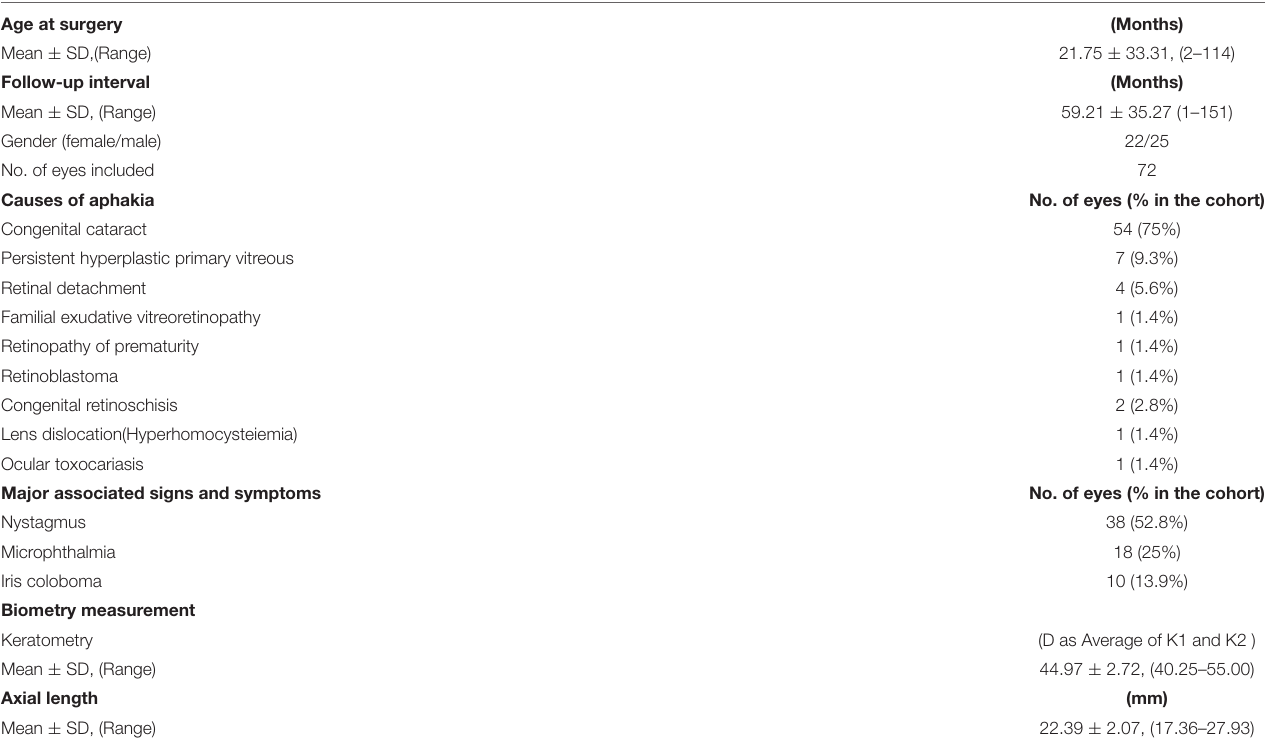
TABLE 1 | Baseline characteristics of the patients and eyes included in the